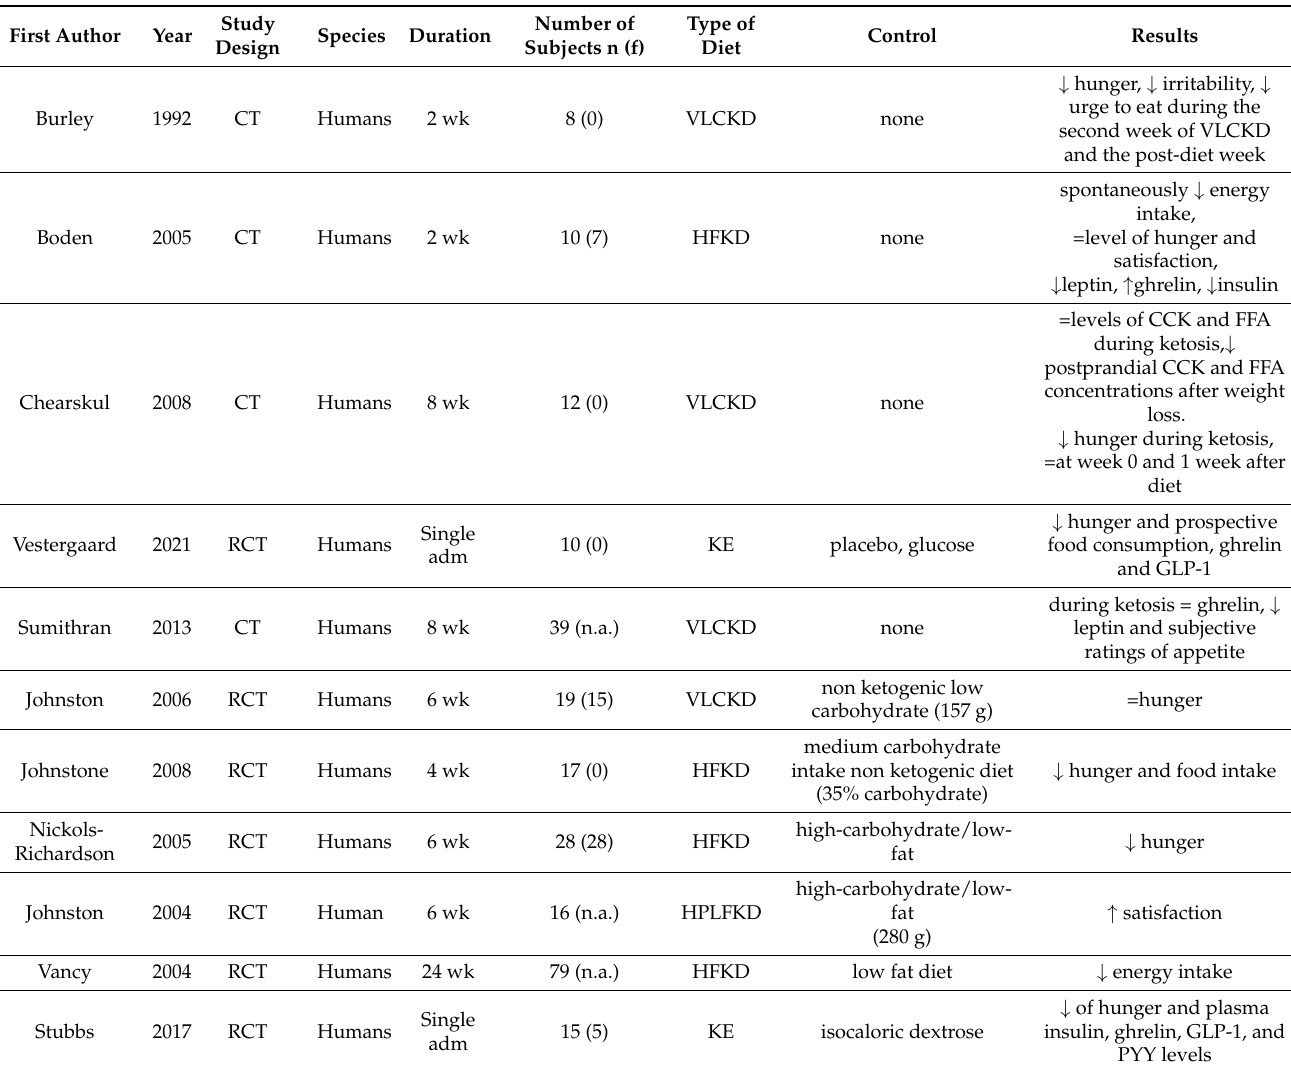
Table 1. Selected studies regarding the effect of a ketogenic diet or ketone bodies on appetite